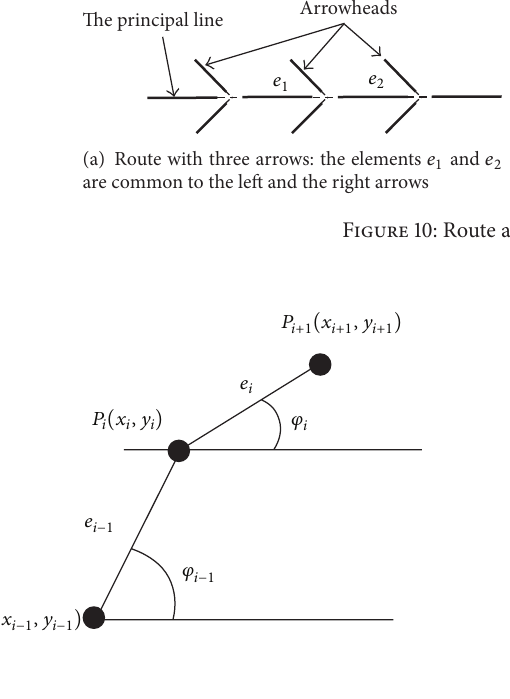
Figure 11: Curvature for digital